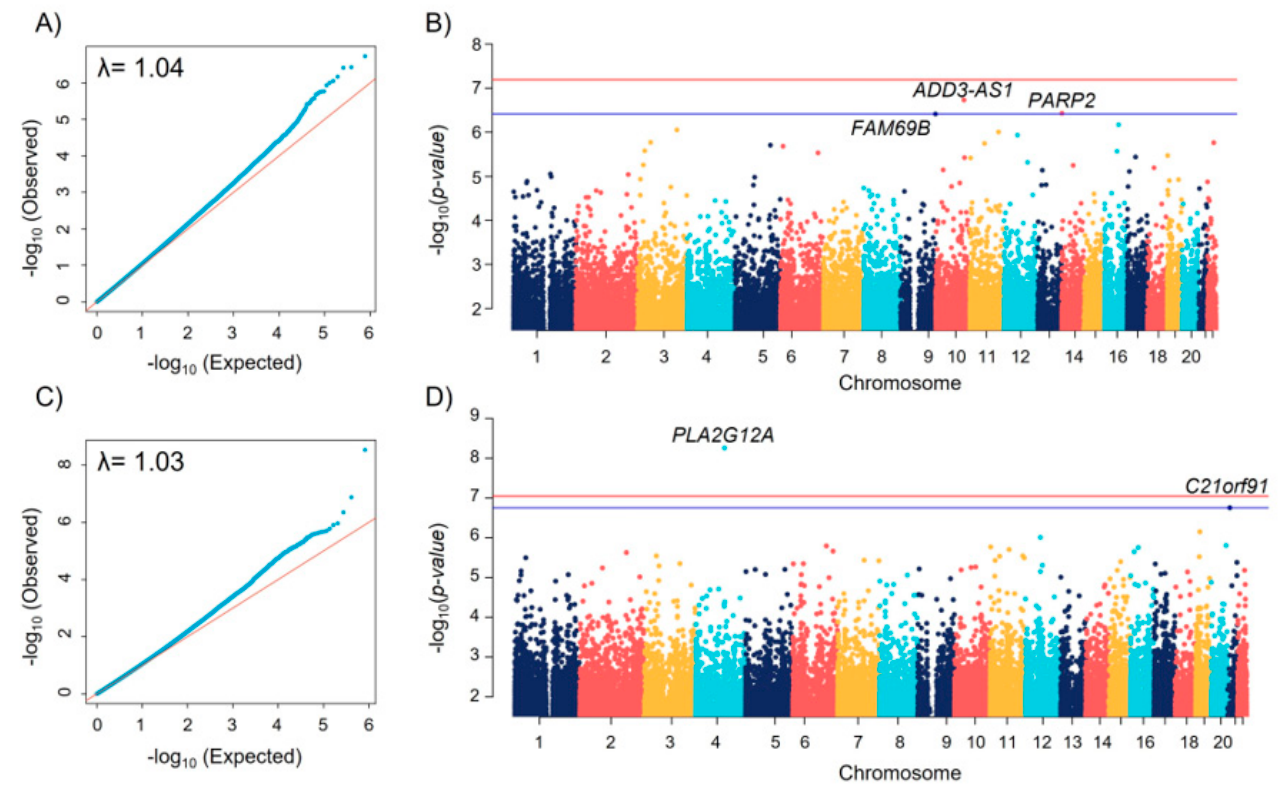
Figure 1. ( A ) Q-Q plot of p -values of the EWAS of BDR. ( B ) Manhattan plot for the EWAS of BDR. This figure illustrates the position of each CpG arranged by chromosomal location (X-axis) and the level of statistical significance measured by the negative logarithm of the corresponding p -value (Y-axis). The blue and red lines represent the FDR < 0.1 and genome-wide thresholds, respectively.